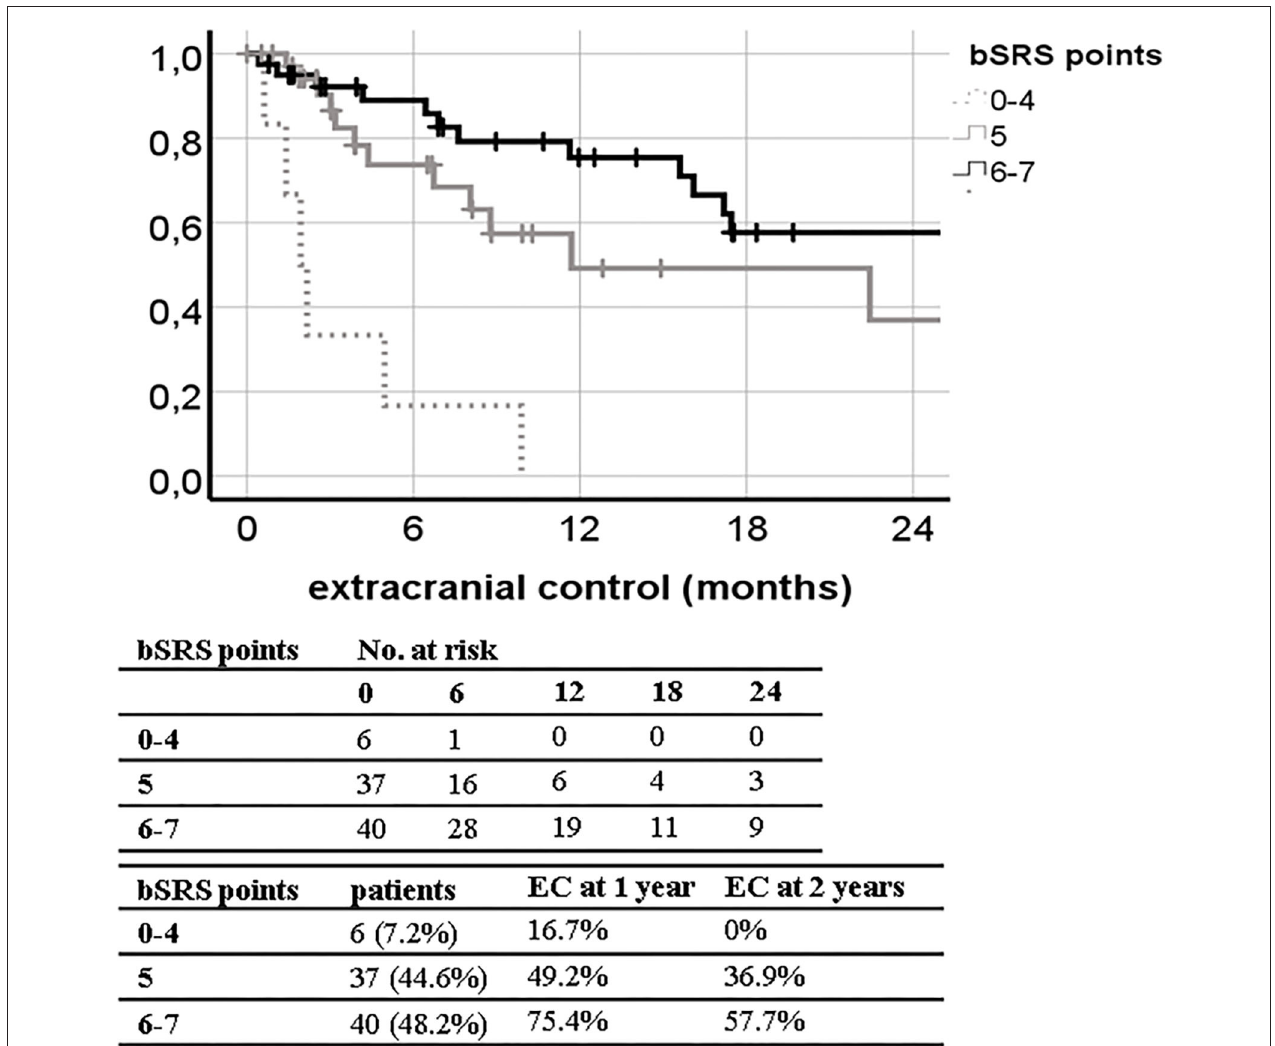
FIGURE 6 | Kaplan–Meier curves for extracranial control (EC; n = 83) divided by the breast scoring tool for stereotactic therapy (bSRS) in our patient population (log-rank p < 0.001; concordance index 0.596; 95% CI, 0.465–0.728; p = 0.143) with 1- and 2-year EC